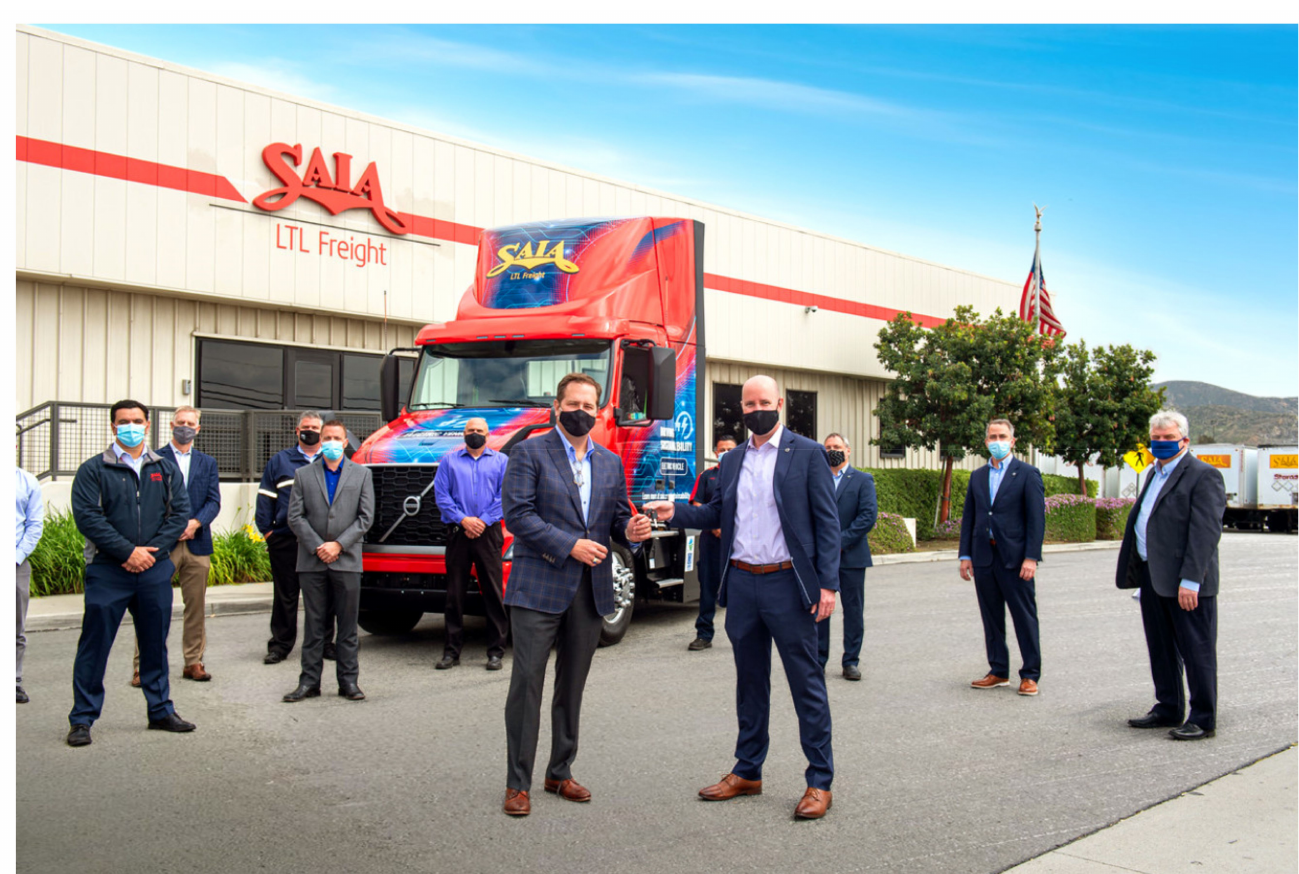
Figure 3. Saia executives, drivers, technicians, and Volvo Trucks North America (VTNA) representatives during Saia’s first Volvo VNR Electric delivery, where VTNA representatives explained details of the truck and its operation to the SAIA